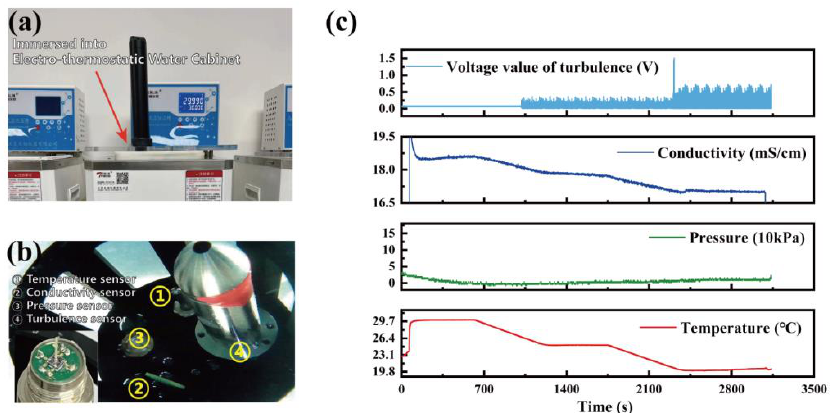
Figure 17. Four-parameter space-time synchronization test: ( a ) experimental apparatus; ( b ) sensors in water cabinet; ( c ) experimental results